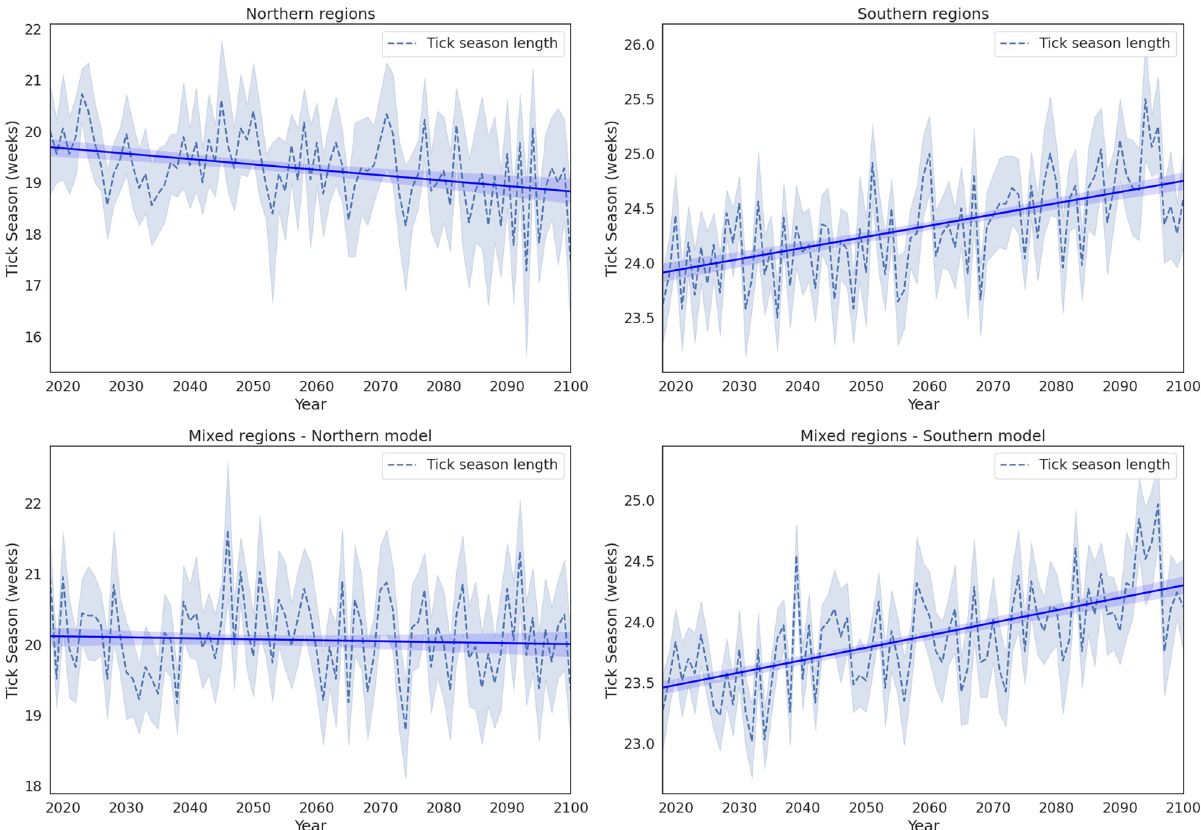
Fig 7. Tick season length predicted by the LSTM model for the Northern cluster (top left panel), Southern cluster (top right panel) and mixed cluster (bottom panels). For the mixed cluster, since both tick species are found there, both models were used to make predictions.